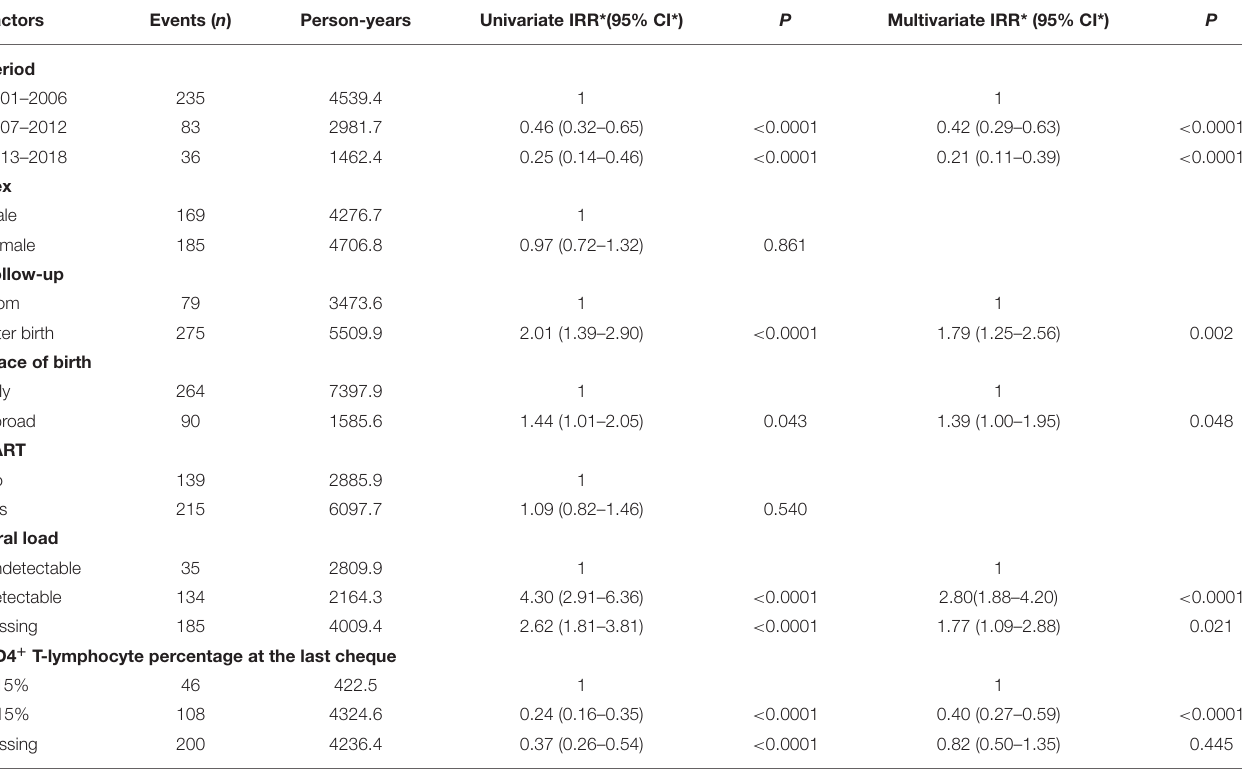
TABLE 7 | Opportunistic infections rates among the study periods, adjusted for sex, starting of follow up, child’s origin, use of cART, viral load, and CD4 + %.